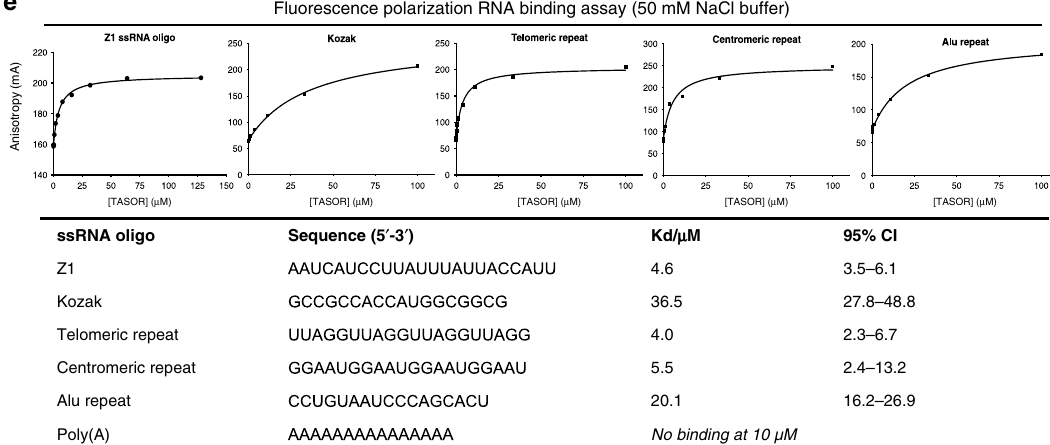
Fig. 5 TASOR is a pseudo-PARP. a Active site comparison of PARP1 and TASOR, showing key functional residues. b Transgene repression assays show that mutation of the degenerated TASOR PARP active site does not affect TASOR function. c TASOR PARP domain does not bind promiscuous PARP inhibitor benzamide. DSF of three replicates, shown are mean ± standard deviation. d Full-length PARP1 auto-PARylates in the presence of dsDNA and NAD + but TASOR PARP domain is not signi fi cantly affected. e Binding of 5 ’ (6-FAM)-labeled ssRNA oligonucleotides to TASOR(106 – 332) by fl uorescence polarization (FP), with a table summarizing the binding data. Source data for ( c – e ) are provided in the Source data fi